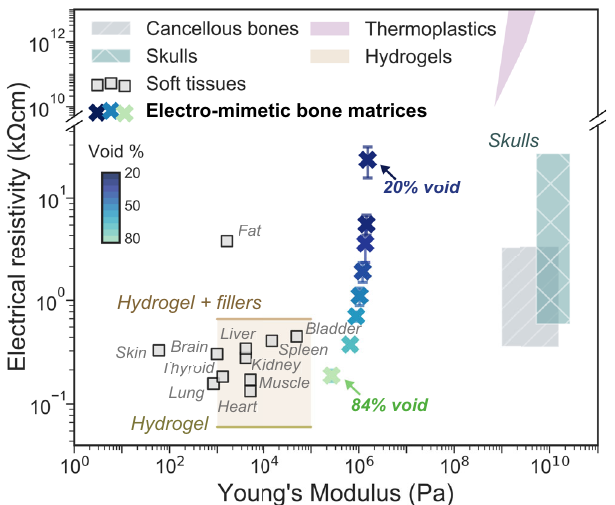
Fig. 3 Wide resistivity tuneability and adequate mechanical properties of electro-mimetic bone matrices. A map of resistivity versus Young ’ s modulus of human tissues, thermoplastics, the hydrogel- fi llers matrices and the electro-mimetic bone matrices (plateau values) was tested in this study ( n = 3 independent samples). The compositions of the hydrogel and hydrogel- fi llers matrices tested here are listed in Supplementary Fig. 5a. Young ’ s modulus of the electro-mimetic bone matrix was estimated by scaling Young ’ s modulus of pure PDMS (1.7 MPa at a curing temperature of 60 °C 55 ) linearly with the f void of the matrix. Tissues and thermoplastics data and Young ’ s modulus of hydrogels were compiled from literature 22 – 27,56 – 60 . Data of the electro-mimetic bone matrices are presented as mean values ±